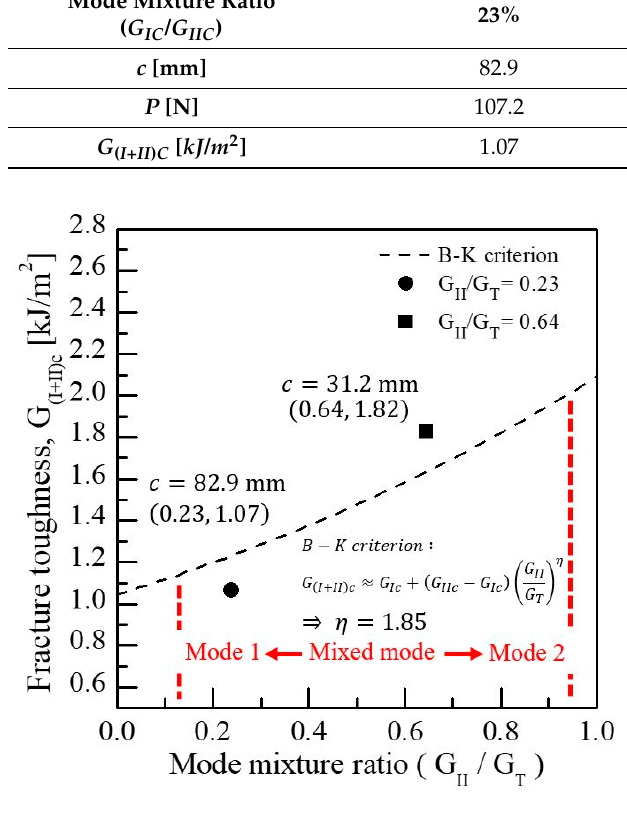
Figure 10. B–K criterion curve of Mixed-mode test results.